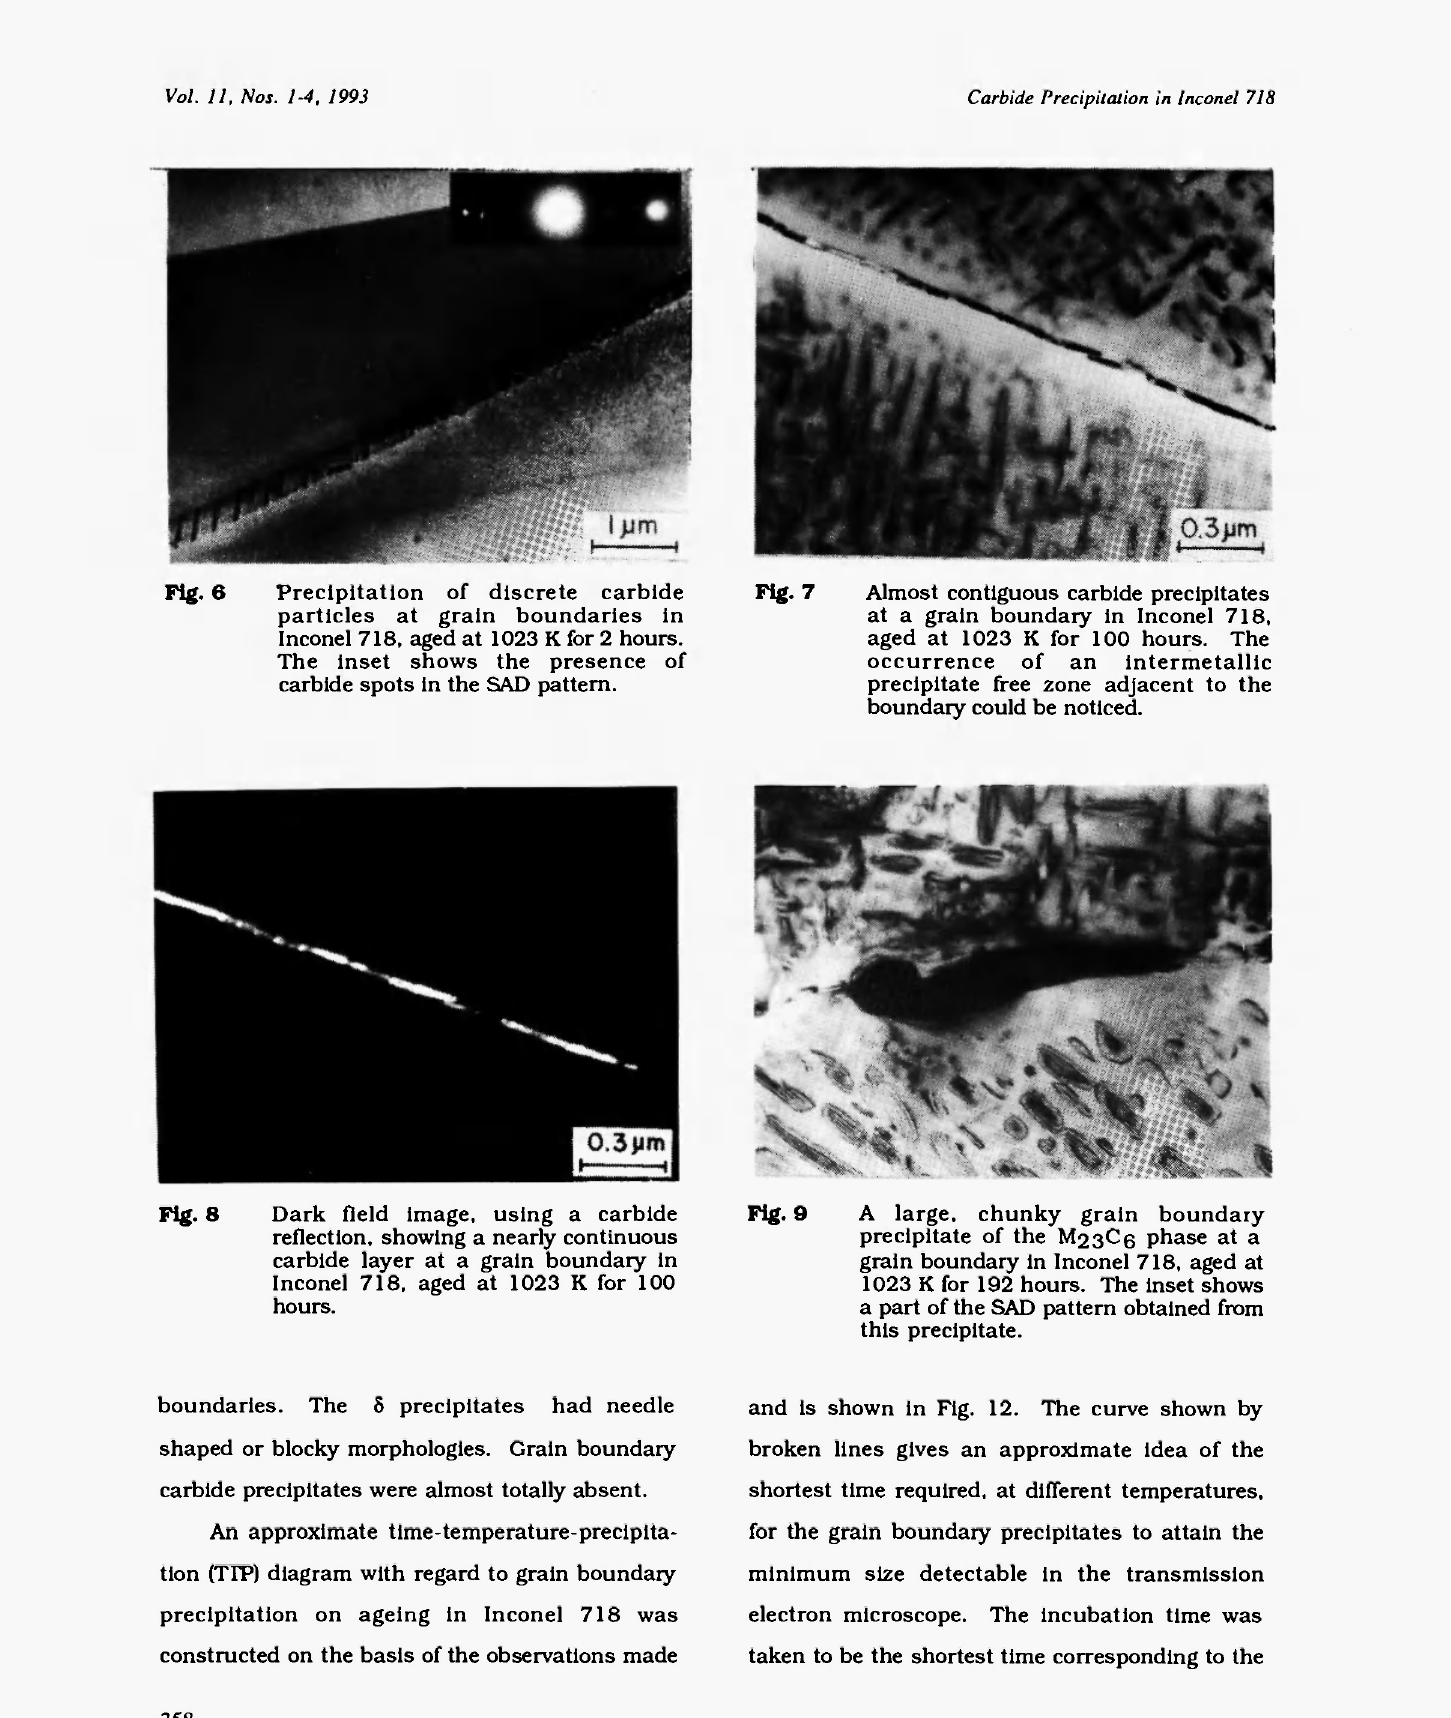
Fig. 8 Dark field image, using a carbide reflection, showing a nearly continuous carbide layer at a grain boundary in Inconel 718, aged at 1023 Κ for 100 hours.